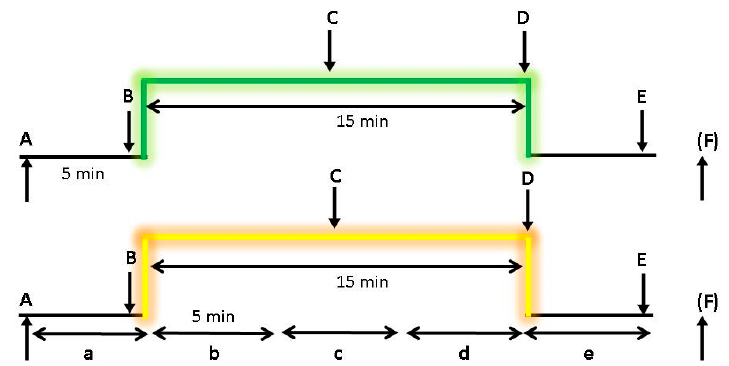
Figure 3. Measurement profile with analysis time intervals (a–e) and time points (A–F) for green and yellow laser stimulation. For the temperature measurement, an additional point (F; 15 min after point E) was used.